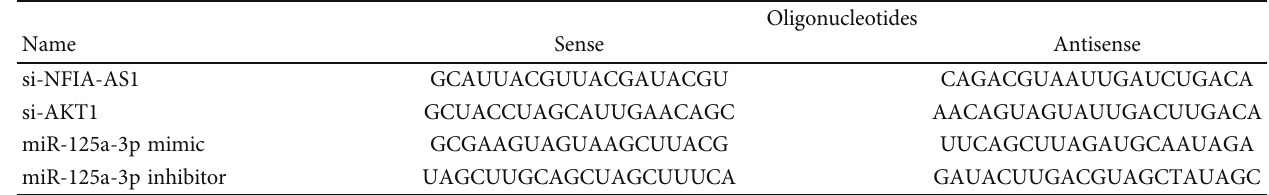
Table 2: Oligonucleotides for transfection.